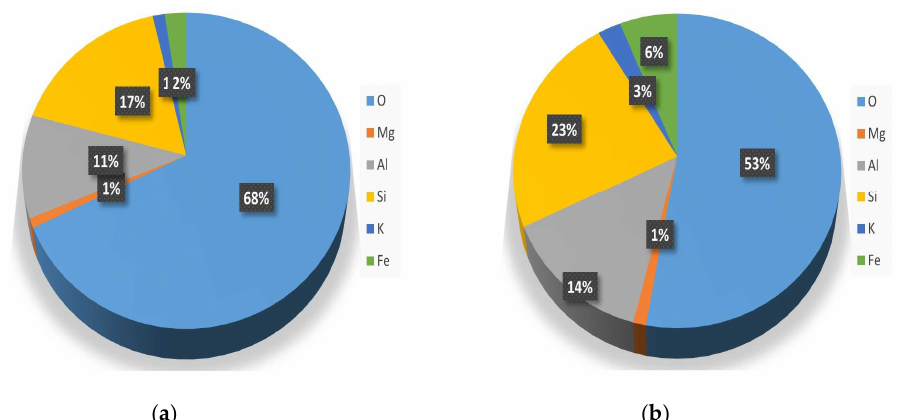
Figure 2. The atomic ( a ) and mass ( b ) share of the elements in natural clay.